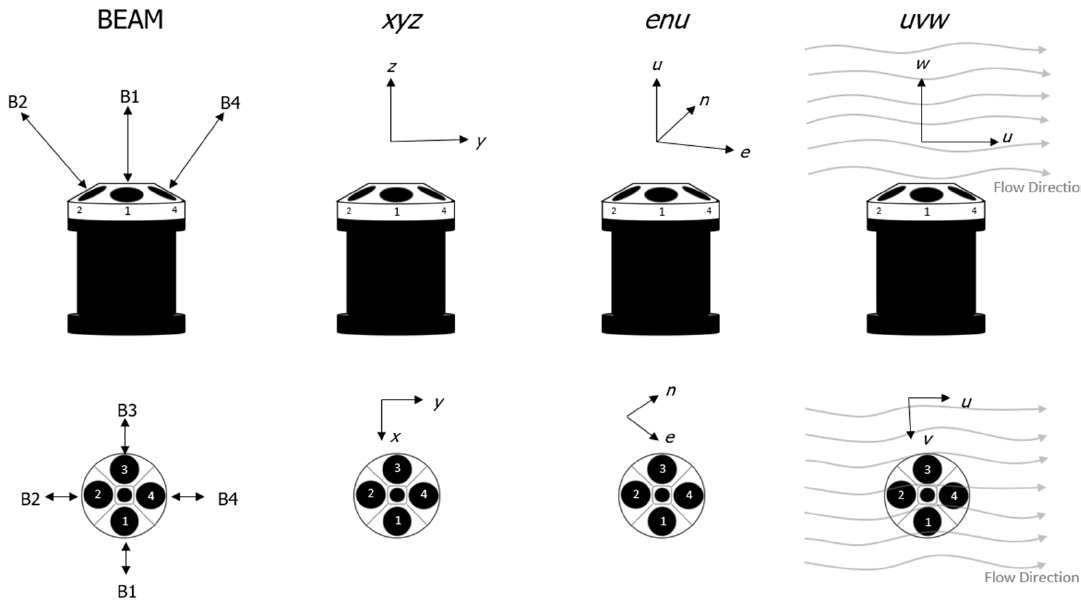
Figure 2. Divergent acoustic Doppler profiler beam coordinates relative to xyz , enu and uvw .